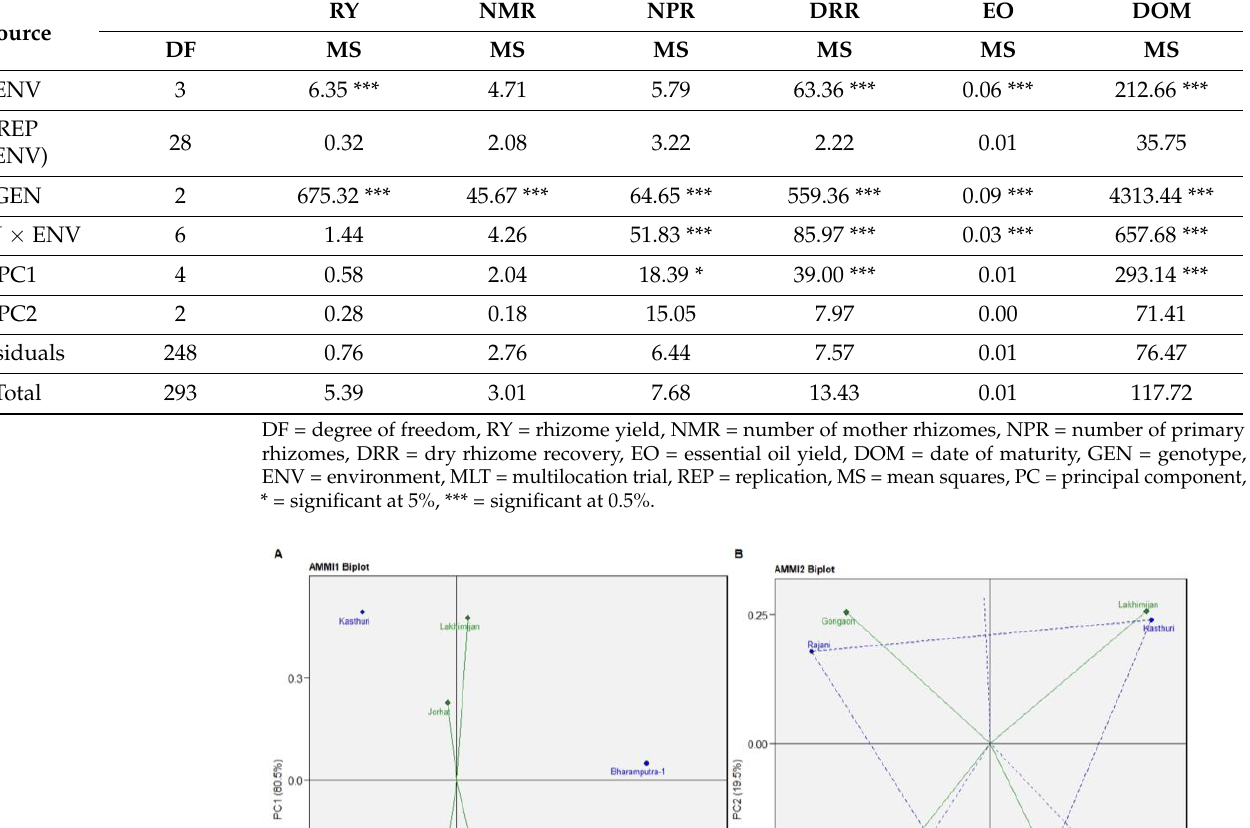
Table 6. AMMI analysis of variance of the six traits for three selected genotypes in MLT . Source